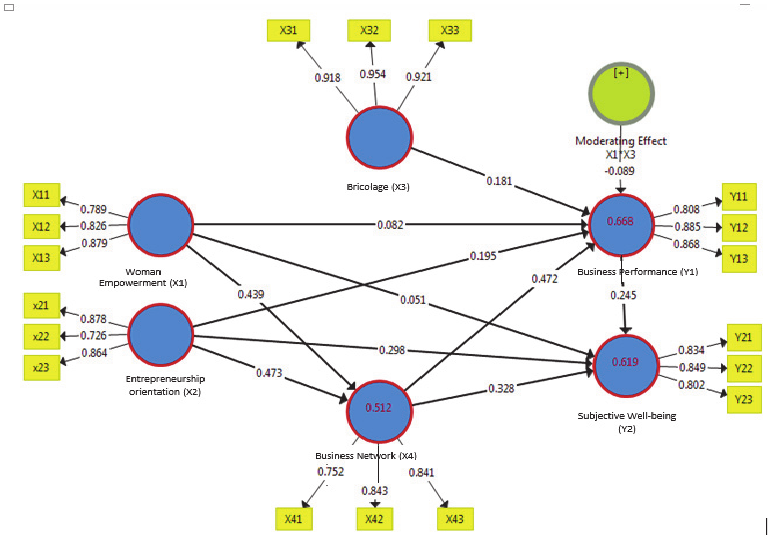
Fig. 1. The full structural